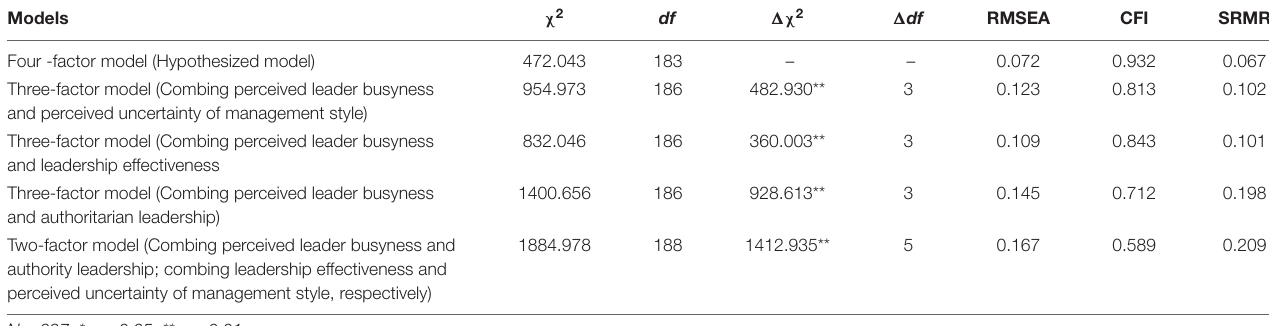
TABLE 3 | Confirmatory factor analysis.